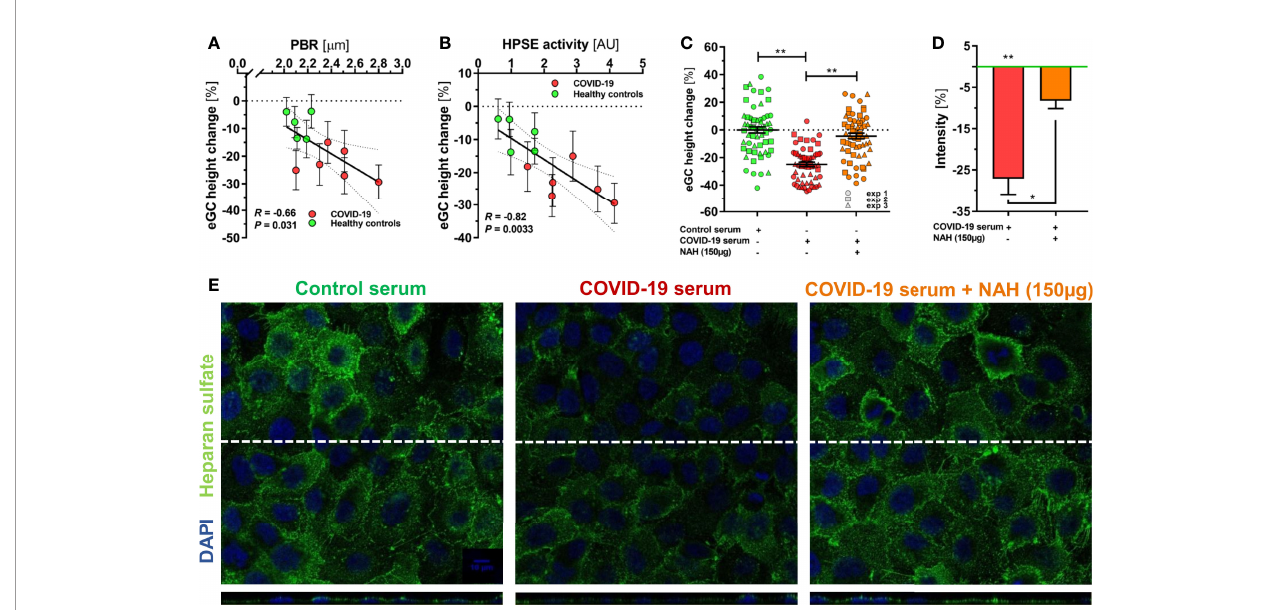
FIGURE 2 | HPSE is a putative mediator of eGC damage in COVID-19. (A-C) Sera from a randomly selected subgroup of 5 healthy controls and 6 COVID-19 patients were sterile- fi ltered and incubated (5%) on the human umbilical vein endothelial cell line EA.hy926 for 60 min. Endothelial glycocalyx (eGC) thickness was assessed by atomic force microscopy (AFM) using a dedicated nano-indentation protocol. Scatter dot plot showing the association between AFM-derived eGC ( in vitro ) decline and corresponding (A) PBR-values ( in vivo ) and (B) HPSE activity for the individuals from the subgroup. Each dot represents the mean ± SEM (standard error of mean) of two independent AFM experiments (consisting of ≥ 4 indentation curves in each of ≥ 8 different cells) for each individual serum. Incubation without human serum served as control. Correlation was assessed by Spearman correlation coef fi cient. (C) Dot plots from three independent AFM experiments (pooled serum from subgroups) showing values with mean ± SEM. Each dot represents the mean of ≥ 4 indentation curves per cell. Heparanase was blocked by N-desulfated re-N-acetylated heparin (NAH; 150 µg). Differences between groups were calculated with nested ANOVA and Tukey ’ s post-hoc test. Intensity analysis of heparan sulfate-stained EA.hy926 cells (D) and representative immuno fl uorescence images (E) after treatment with 5% control serum or COVID-19 serum ± NAH (150 µg) for 60 min. Values are normalized to control serum (zero line) and differences between groups were assessed with nested ANOVA and Tukey ’ s post-hoc test. Data are presented as mean ± SEM. *p < 0.05; **p <